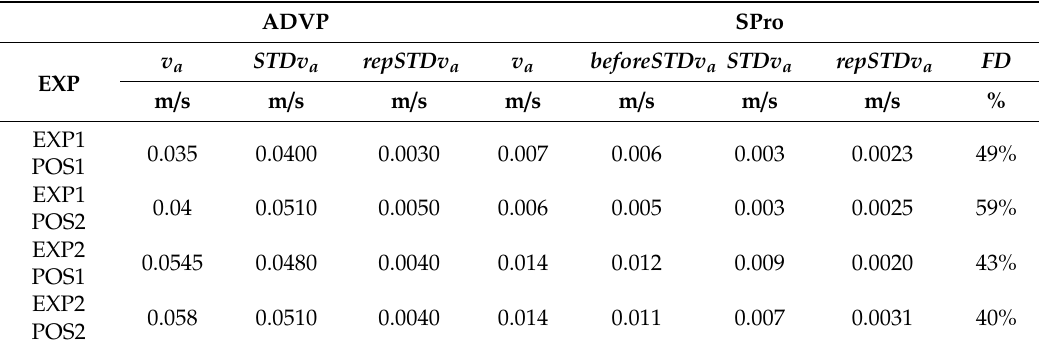
Table 5. The apparent bedload velocity variability in the UbiBo